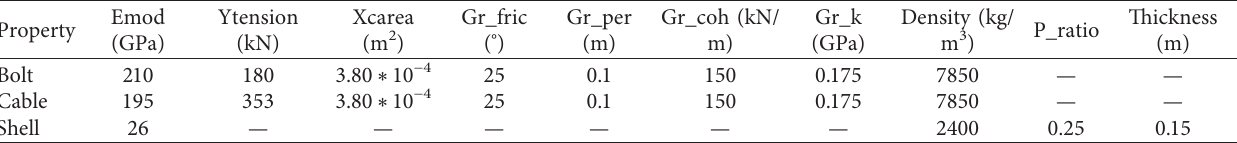
Table 3: Parameters of the structural elements.